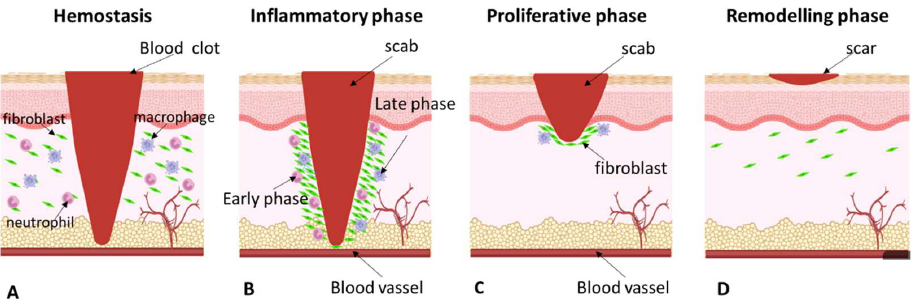
Figure 1. Wound-healing process. The wound healing process is commonly categorized into four distinct phases: ( A ) Homeostasis (coagulation); ( B ) inflammatory phase (early/ late inflammation); ( C ) proliferative phase (proliferation/migration/epithelialization/granulation); ( D ) remodeling phase (maturation/repair). ( A ) Hemostasis: A clot is formed, providing a temporary barrier to fluid loss and pathogen entry; acts as a reservoir of bioactive factors and antimicrobials; provides provisional extracellular matrix, which supports immune cell infiltration and migration; and initiates tissue repair pathways. ( B ) Inflammatory phase: Early step with damage-associated molecular patterns activation, free radicals, and reactive molecular species production to recruit immune cells; release of antimicrobial species; infiltrating immune cells that secrete amplifying alarmin signals (endogenous, constitutively expressed, chemotactic, and immune-activating proteins/peptides that are released as a result of degranulation, cell injury or death, or in response to immune induction), and activation of keratinocytes and fibroblasts. ( C ) Proliferation phase: Migration and proliferation of keratinocytes, fibroblasts, endothelial; resolution of inflammation; collagen/extracellular matrix synthesis; decreased vessel permeability; new capillary and lymphatic vessel angiogenesis; epithelialization; and de novo formation of granulation tissue. ( D ) Remodeling (maturation): Collagen/extracellular matrix turnover (synthesis and degradation); extracellular matrix reorganization and realignment; extracellular matrix contraction; endothelia and fibroblast apoptosis; repigmentation.